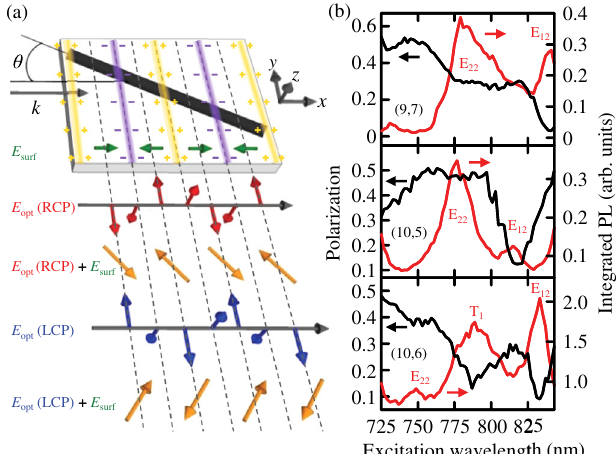
use the fact that linear polarization parallel to the tube